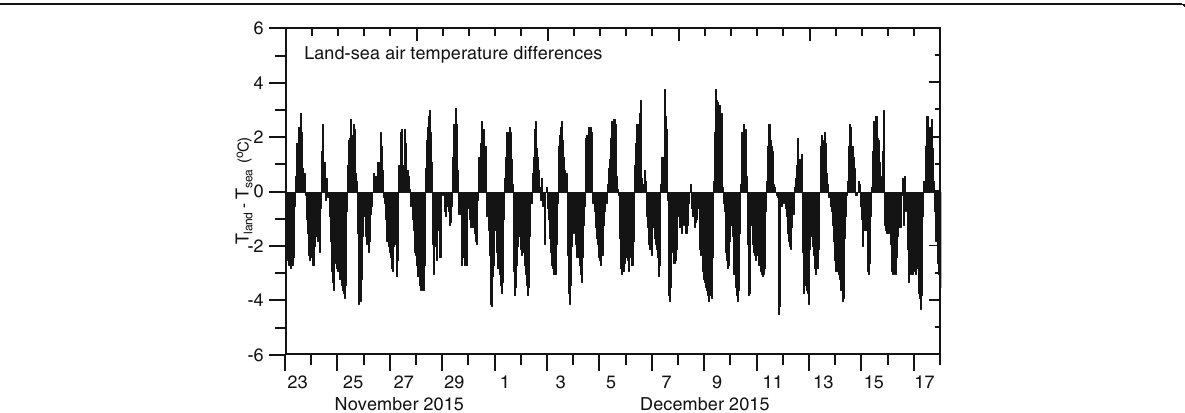
Fig. 7 Time series of air temperature differences between the land (at Bengkulu) and the adjacent sea (on the research vessel Mirai) from 23 November to 17 December 2015. Positive values indicate higher temperatures on the land, and negative values indicate higher temperatures over the sea. The tick marks in the abscissa indicate 00 LT for each of the days within the time period shown